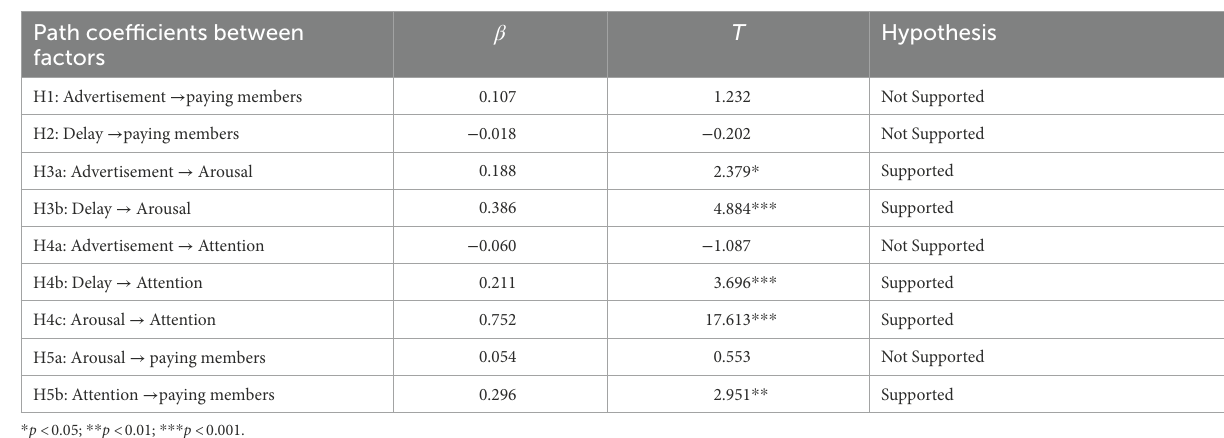
TABLE 4 SEM results for structural